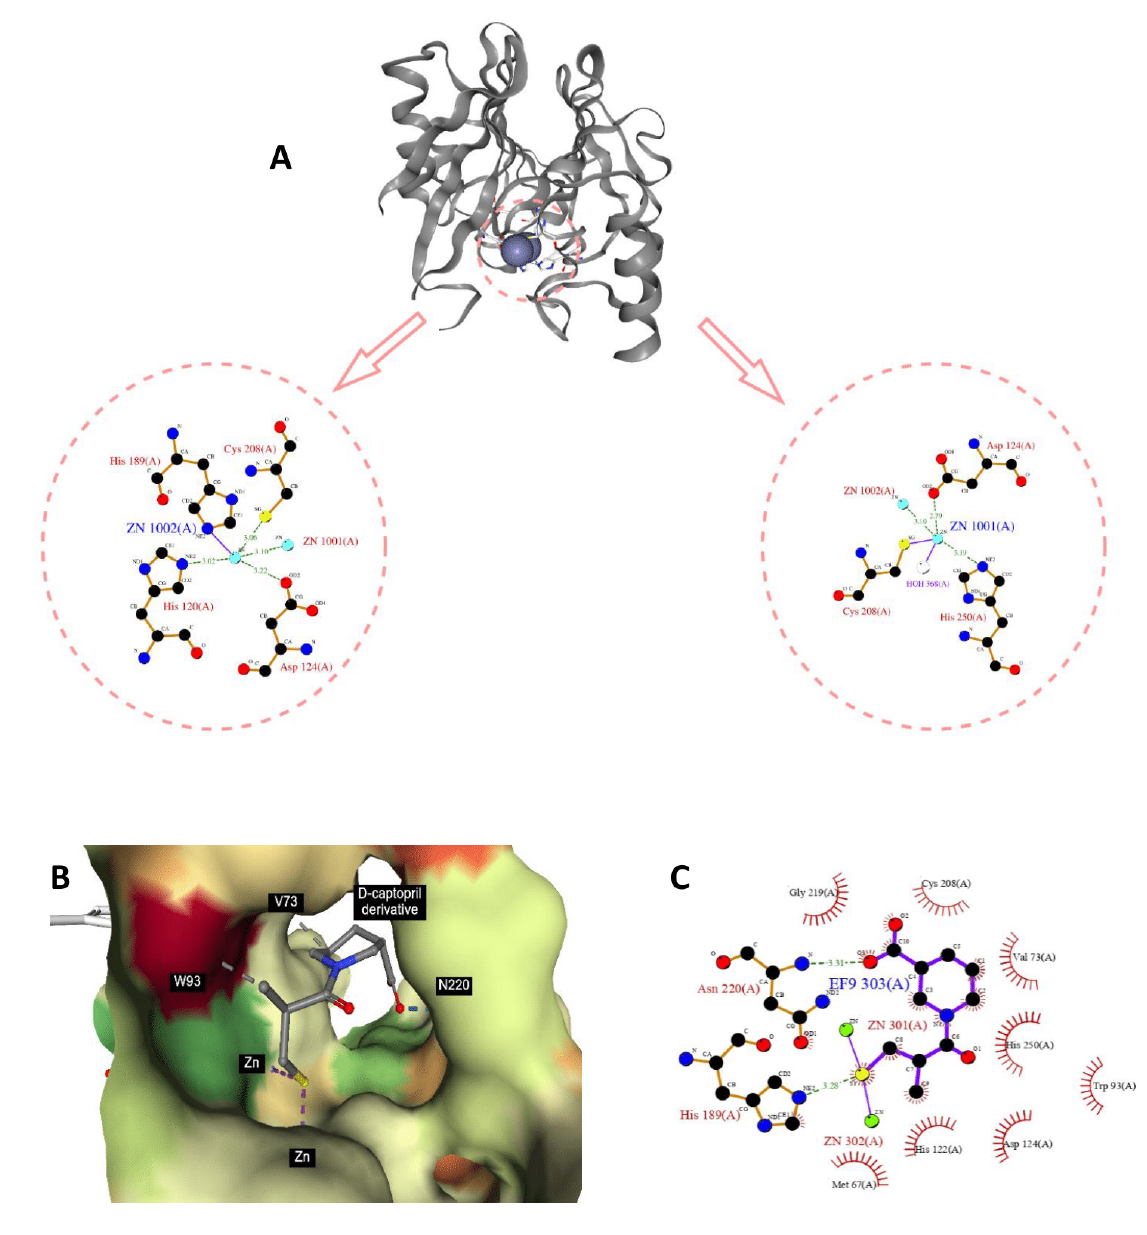
Figure 7: NDM-1 crystal structure and active site. From PDB 3S0Z ( A ). The binding modality of D - captopril derivative against the active site of NDM-1 (PDB ID: 6LJ4) ( B ) and 2D interaction diagram generated by Ligplot+ ( C ), which highlight the role of nitrogen atom and the adjacent aliphatic carbons in stabilization of the protein-ligand